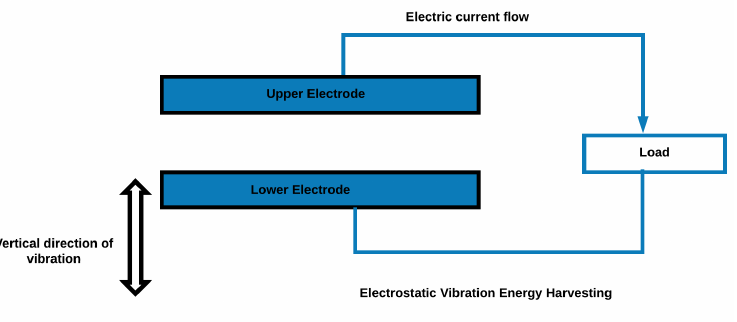
Figure 5. Electrostatic Vibration Energy